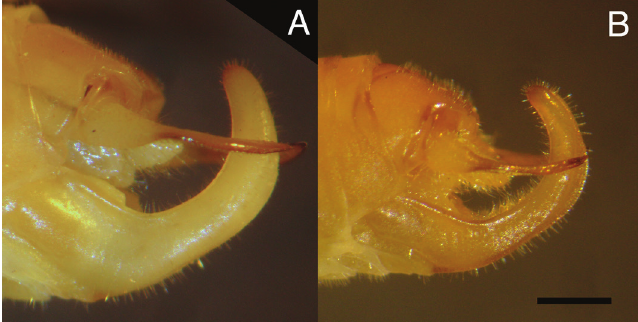
Figure 7. Lateral view of male subgenital plate. A. E. diuturna sp. n., B. E. fulva . Scale 1 mm.